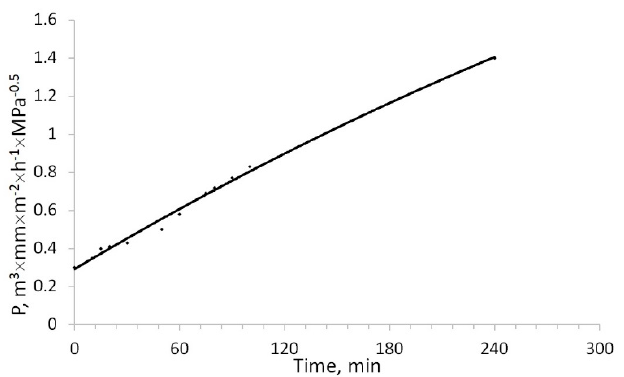
Figure 8. Time dependence of the hydrogen permeability (Q, (m 3 · mm)/(m 2 · h · MPa 0.5 )) of a Cu-Pd50 membrane foil sample at 320 ° С .